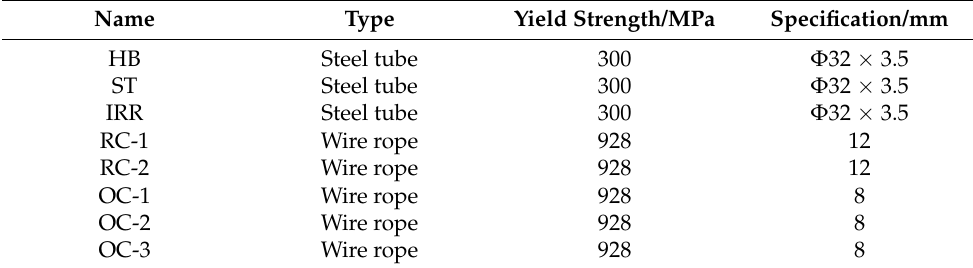
Figure 10. Photographs of the IRR. Details of specimen are shown in Table 1. Table 1. Parameters of specimen